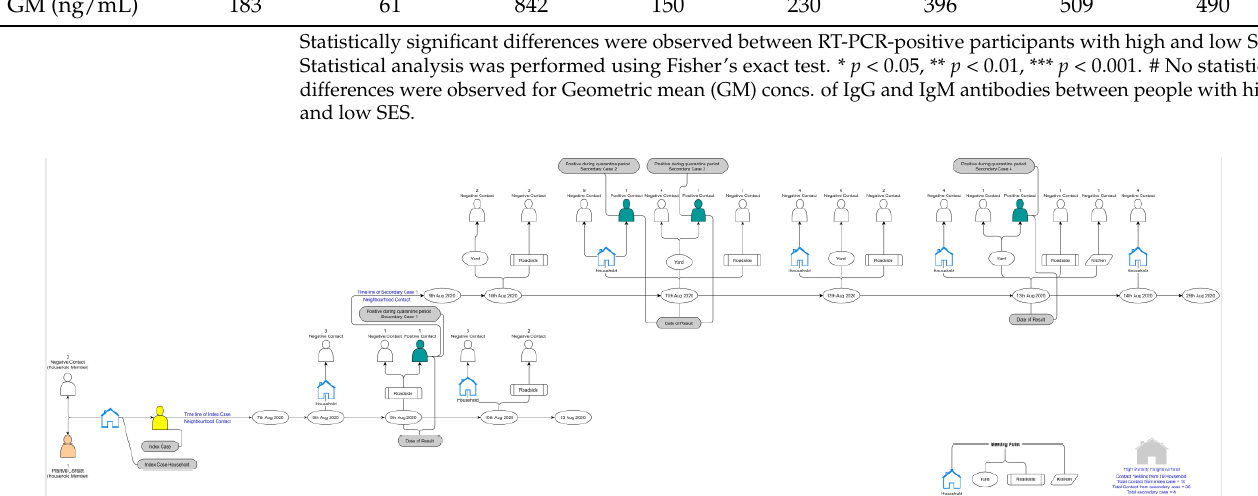
Figure A2. Diagram showing the setting of exposure and the direction of transmission from index case to household and neighborhood contacts in low-density areas in Dhaka city.